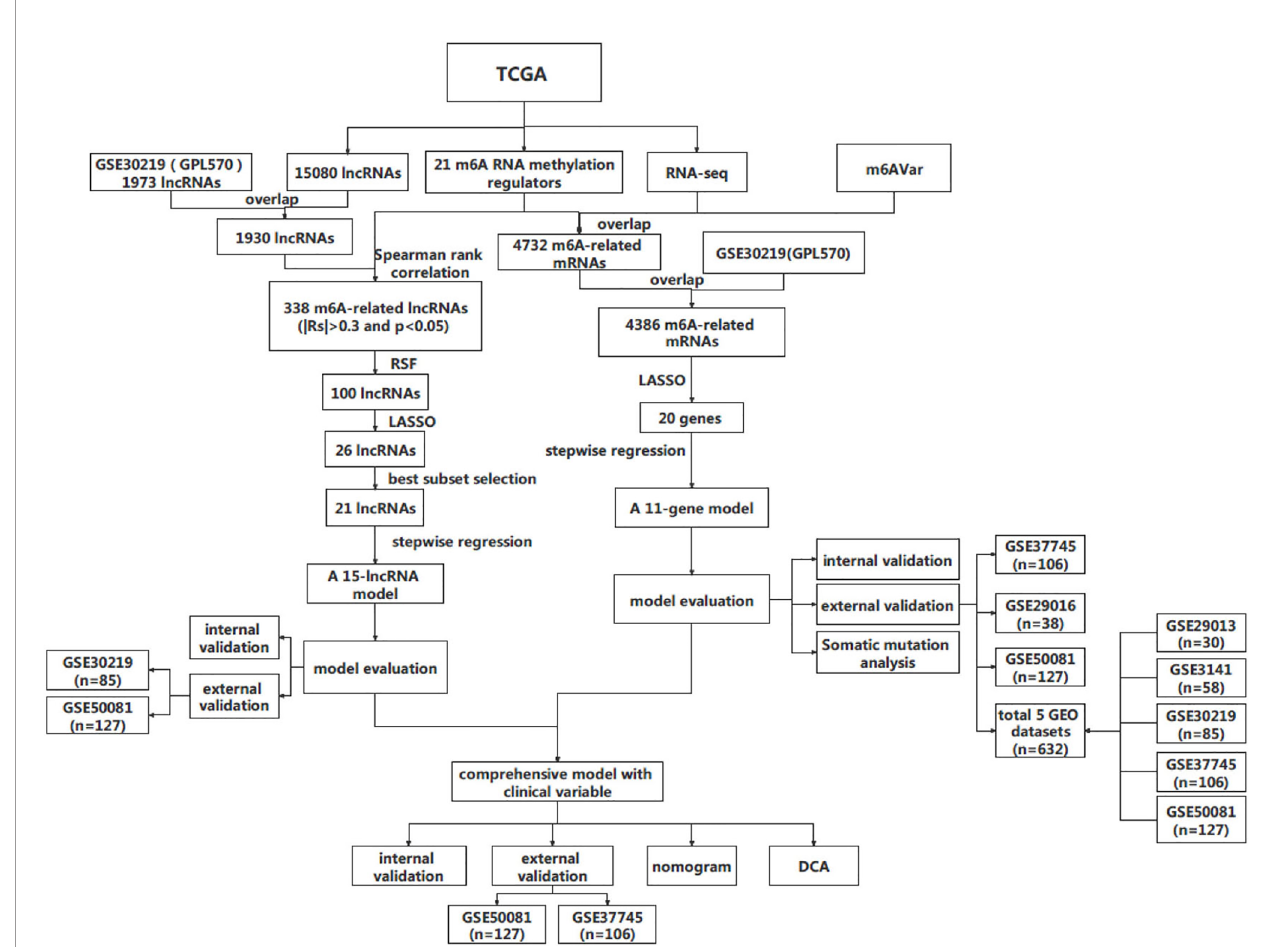
FIGURE 1 | The work fl ow of this study. RSF, random survival forest; DCA, decision curve